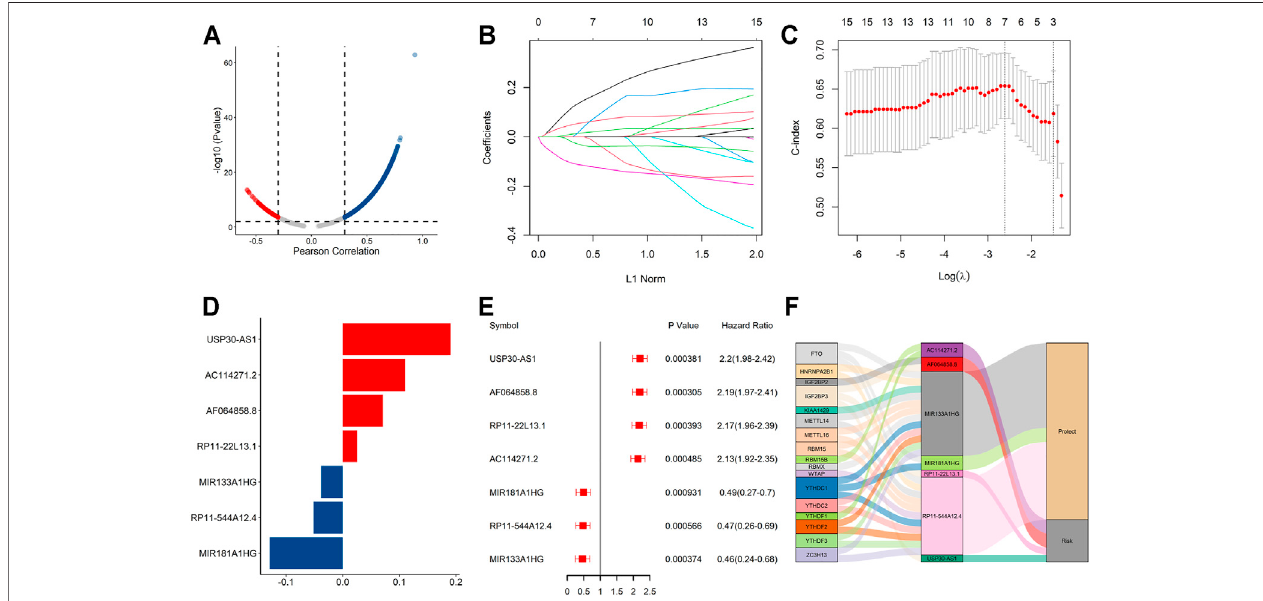
FIGURE 2 | A seven m6A-related lncRNA prognostic signature was constructed for AML patients. (A) Pearson correlation analysis between m6A-related genes and lncRNA expression in AML samples. (B,C) LASSO coef fi cient values and vertical dashed lines were calculated at the best log(lambda) value. (D) LASSO coef fi cient pro fi les of the prognosis-related lncRNAs. (E) Forest plot of the univariate Cox regression analysis for the 7 prognosis-related lncRNAs. (F) The Sankey diagram shows the correlation between m6A genes, m6A-related lncRNAs and the risk type.